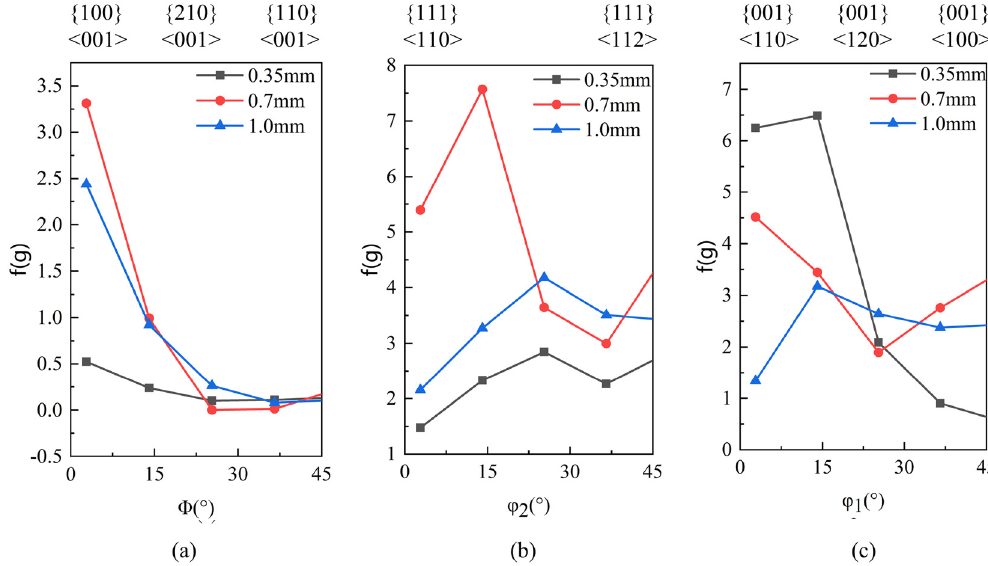
Figure 11: Distribution diagram of orientation lines of Y - bearing specimen: ( a ) η orientation line; ( b ) γ orientation line; ( c ) λ orientation